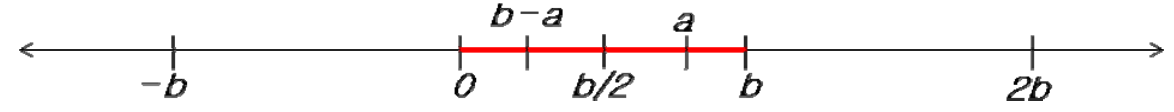
Figure 2b. Model of analytical approach in 1-Dimensional space ( b/2 ≤ a < b